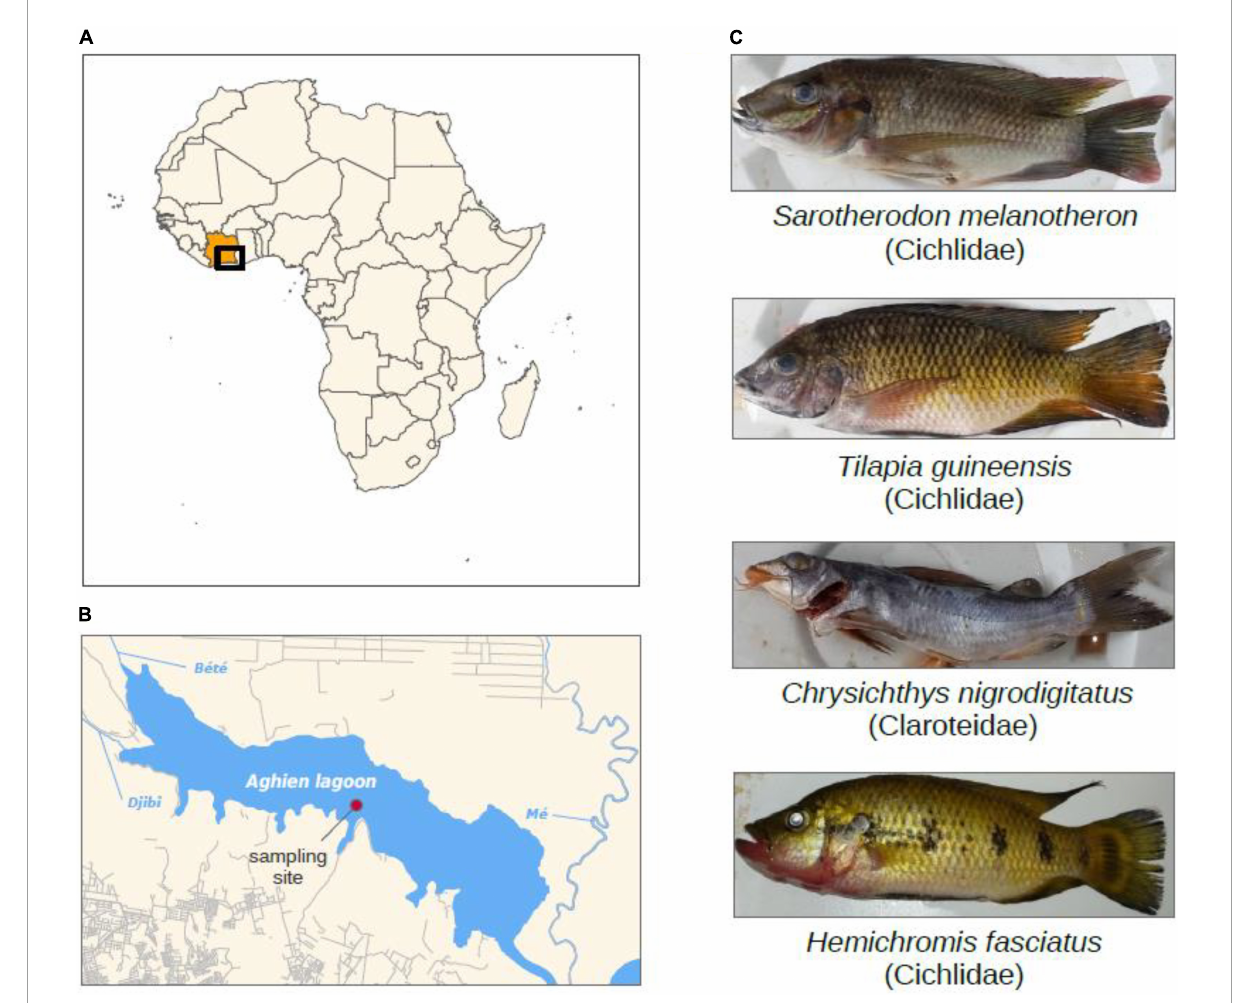
FIGURE1 (A,B) Maps of the study area, the Aghien lagoon, located to the North-East of Abidjan in Ivory Coast (Africa) and water sampling site. (C) Four fish species and water were sampled monthly from the lagoon. Water sampling site is indicated.